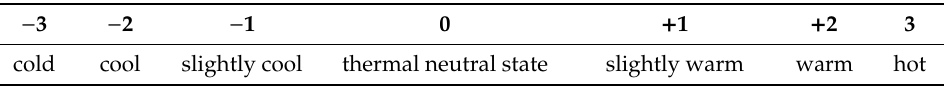
Table 4. Thermal comfort scale based on the predicted mean vote